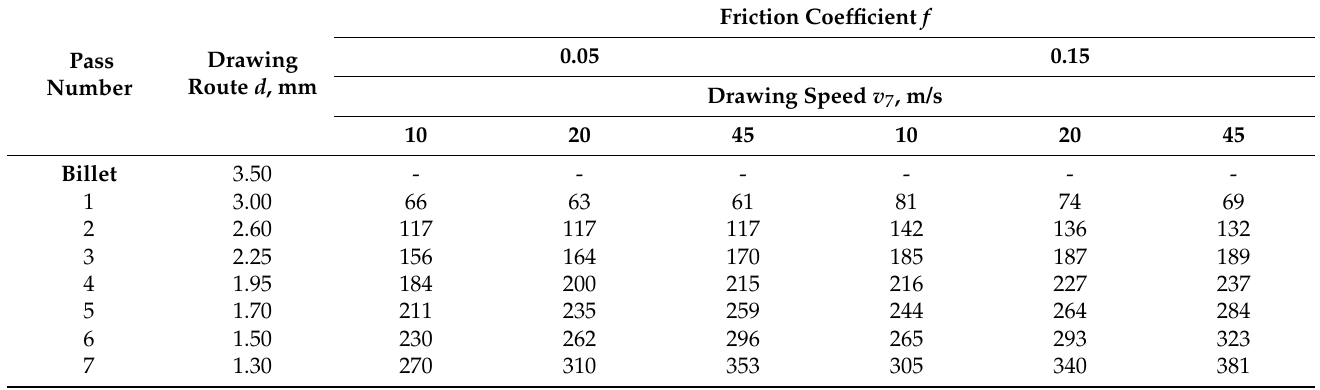
Table 1. Calculation results average temperature of steel (0.2 wt.% C) wire along the drawing